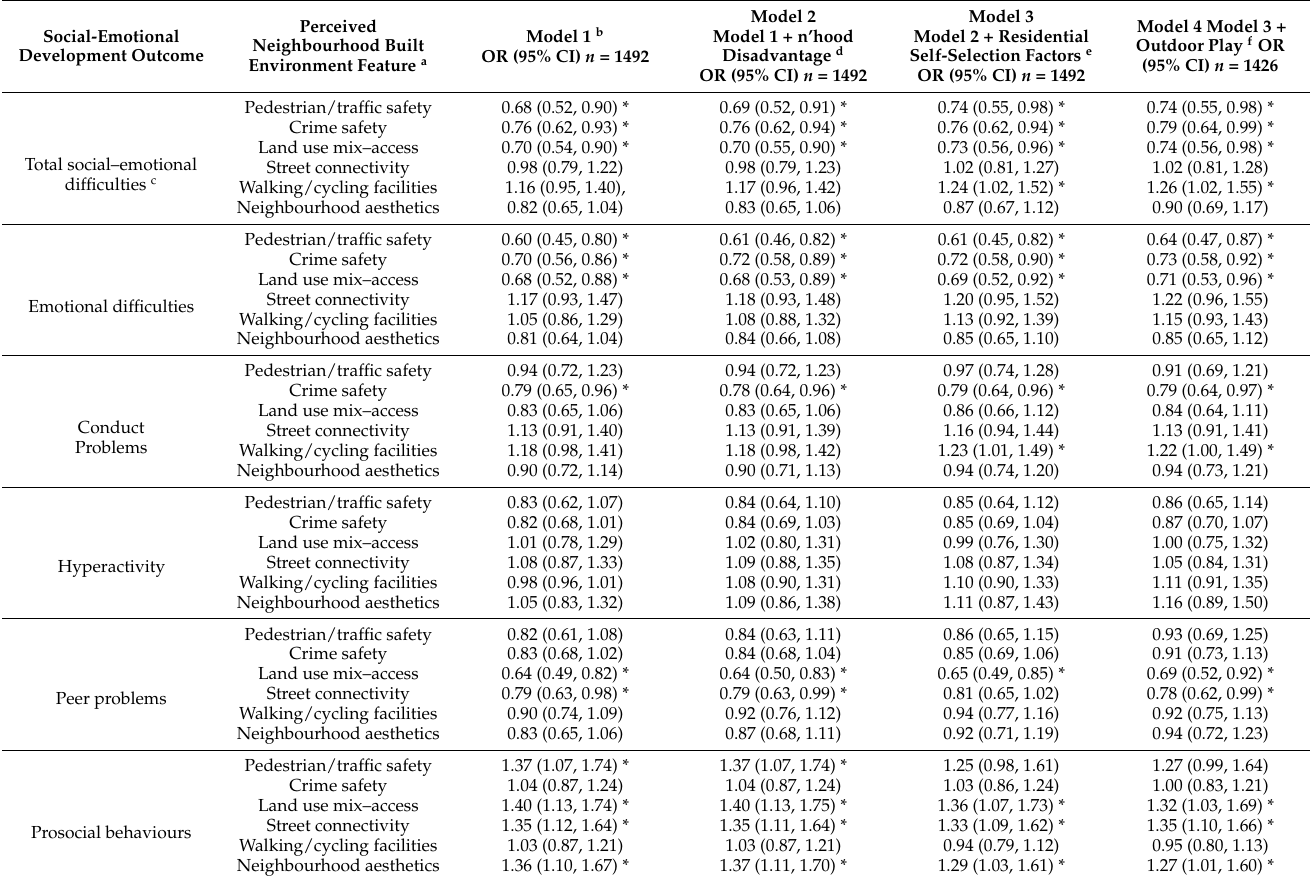
Table 2. Adjusted logistic regression odds ratios examining relationships between perceived neigh- bourhood built environment features and social-emotional development response